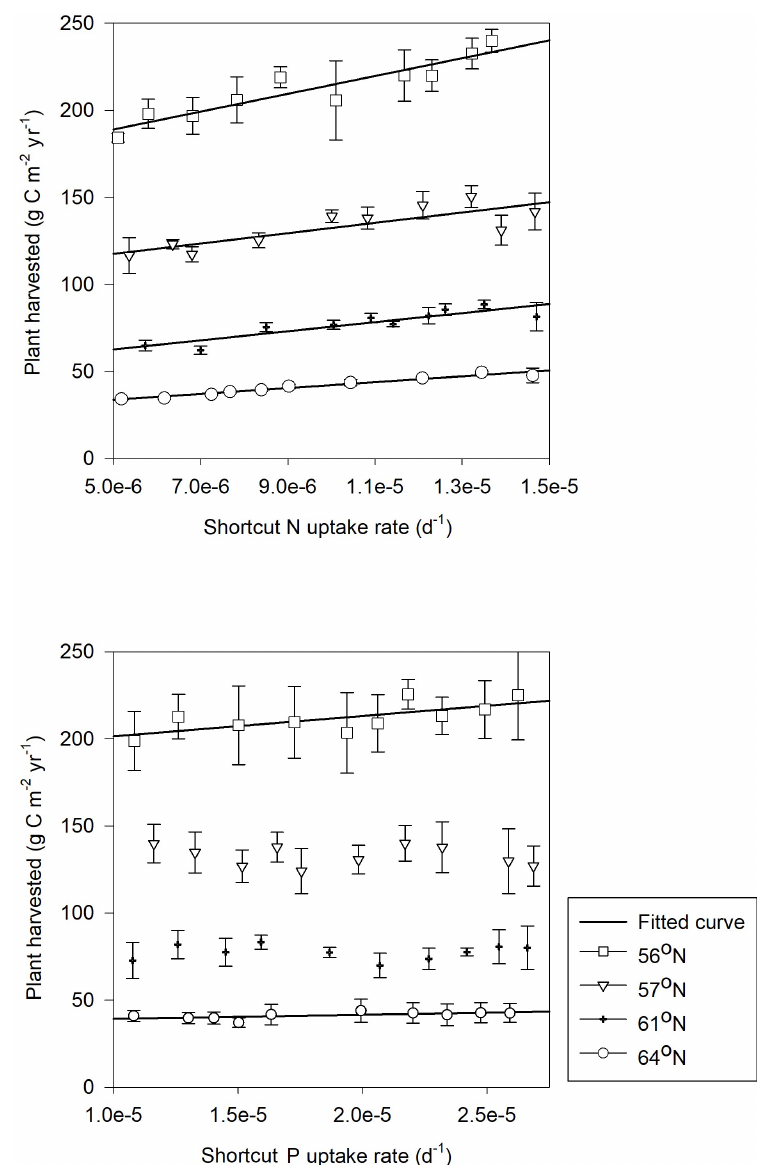
Figure C1. Simulated annual mean harvested biomass amounts for the four studied regions at different shortcut uptake rates for N and P. The bar indicates the standard deviation for each data point (Table